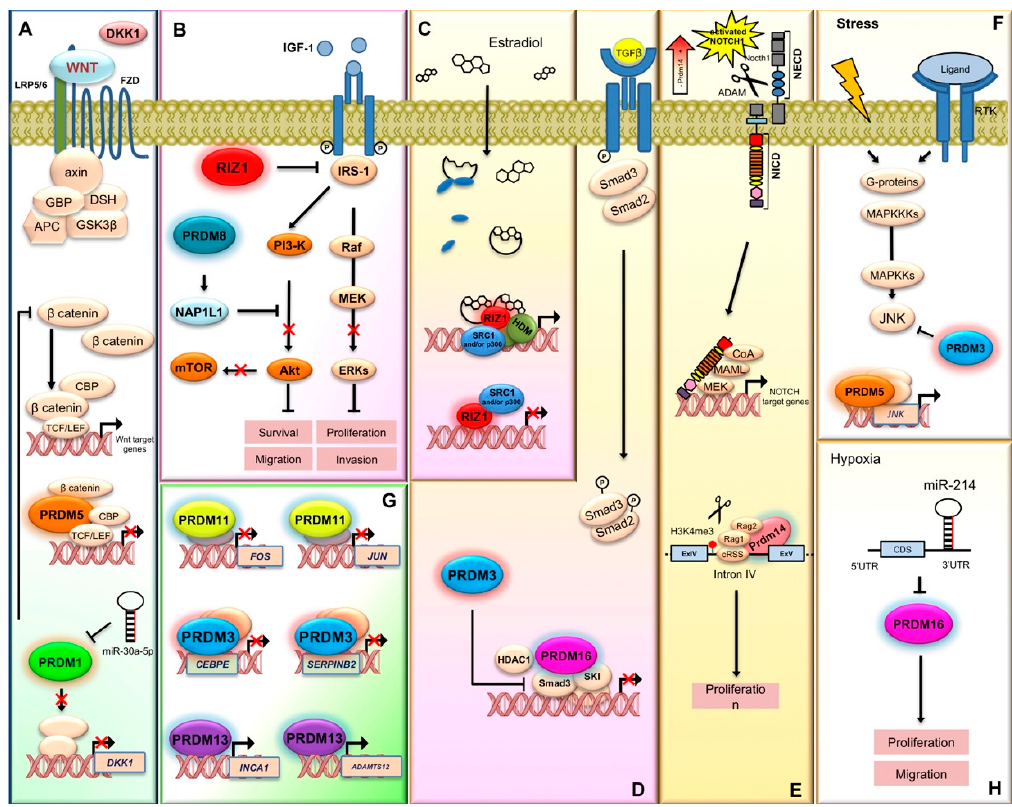
Figure 3. PRDM proteins participation in signal transduction pathways, proliferation, and gene expression regulation . PRDM proteins play a pivotal role in the transduction of signals that control cell proliferation and differentiation. ( A ) PRDM1 and PRDM5 antagonize the Wnt/ β -catenin pathway. PRDM1 reduces the expression of DKK1 while PRDM5 forms a chromatin complex with CBP, TCF, and β -catenin that prevents Wnt target gene expression. ( B ) PRDM2/RIZ1 counteracts the insulin-like growth factor-1 (IGF-1) receptor and the downstream signaling component ERK1/2 and AKT. PRDM8 suppresses the PI3K/AKT/mTOR signaling cascade through the regulation of nucleosome assembly protein 1-like 1 (NAP1L1). ( C ) The PRDM2 gene product, PRDM2a/RIZ1, is a downstream effector of estrogen action and is related to estrogen-regulated cancer cell proliferation. ER α modulates the PRDM2/RIZ isoforms intracellular concentration ratio, by an indirect and selective decrease of RIZ1 expression and a transcriptional activation of RIZ2. ( D ) TGF- β signaling plays important roles in cytostasis and normal epithelium differentiation, and alterations in TGF- β signaling have been identified in many malignancies. MEL1 / PRDM16 interacts with SKI and inhibits TGF- β signaling by stabilizing the inactive Smad3-SKI complex on the promoter of TGF- β target genes. PRDM3 negatively regulates TGF- β signaling through binding and inactivating SMAD3 proteins. (E) PRDM14 binds an intron of NOTCH1 geneandmodifiesthechromatinstructure(H3K4me3)allowingaccessoftheRAGrecombinase complex. RAG deletes part of the NOTCH1 promoter and consequently a truncated, ligand-independent Notch1 protein is produced. ( F ) PRDM3 through its first zinc finger domain, associates and inhibits JNK activity, thus protecting cells from stress-induced cell death that is dependent on JNK activation. Otherwise, PRDM5 upregulates JNK expression. ( G ) PRDM11 represses the oncogenes Fos and Jun that are frequently induced by aberrant growth factor signaling or oncogenic activation of MAP kinase signaling, such as constitutively active RAS. PRDM3 downregulates SERPIN-B2 gene that might play an important role in enhancing cell proliferation by preventing protection of Rb proteolysis and / or in the suppression of cell di ff erentiation. PRDM13 inhibits cell proliferation by upregulating INCA1, a CDK inhibitor and ADAMTS12, a novel antitumor protease that modulates the extracellular signal-regulated kinase signaling pathway. ( H ) Hypoxia-induced miR-214 inhibits PRDM16 expression, thus promoting both cell proliferation and migration and enhancing the Warburg e ff